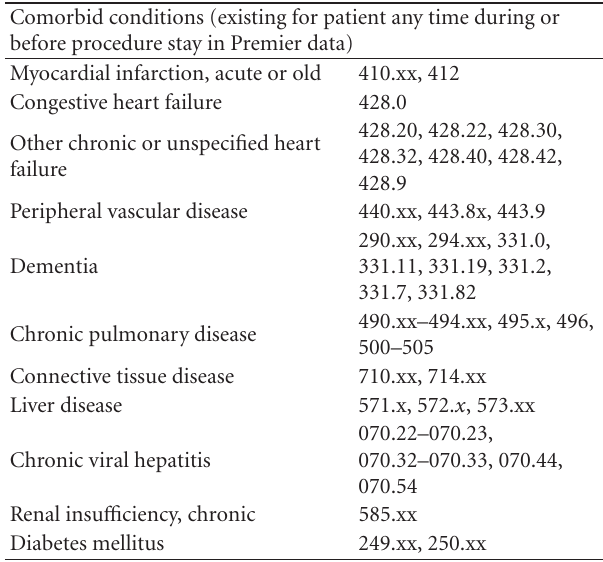
Table 10: Comorbid